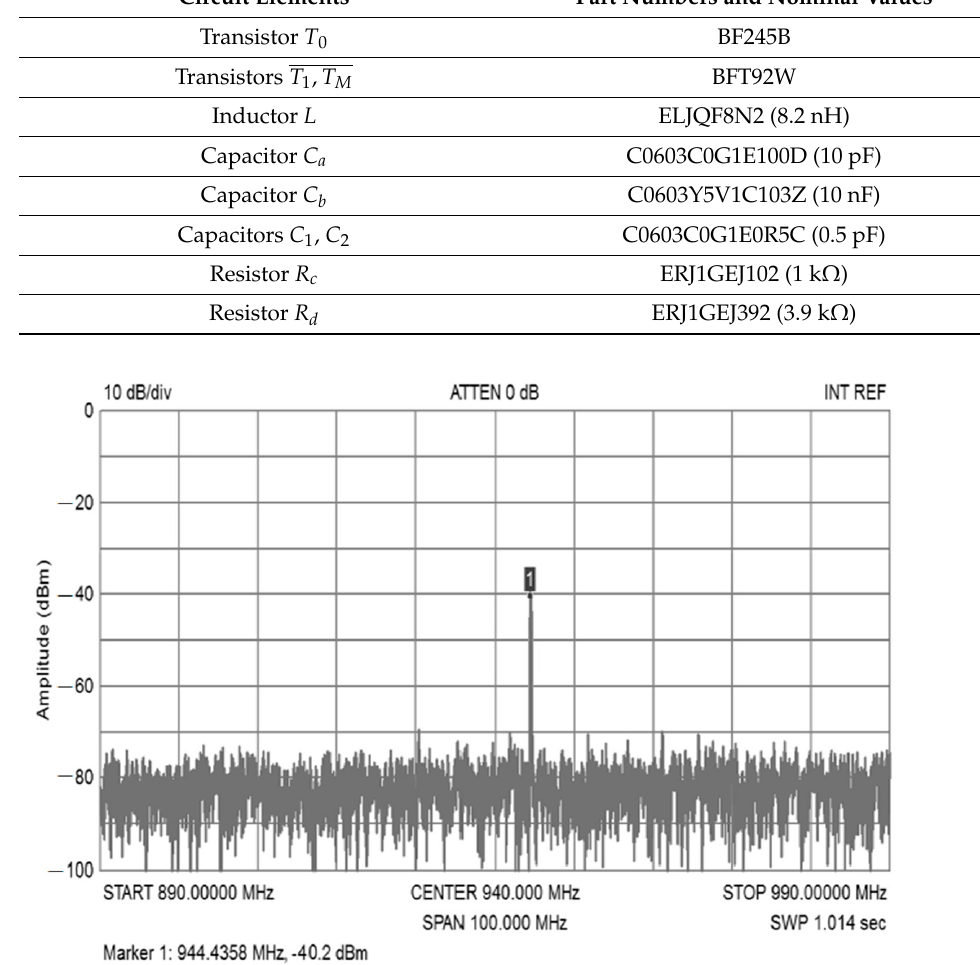
Figure 31. The output spectrum of the oscillator with multiple-output improved Wilson current mirror ( m = 0).